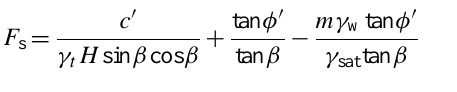
Equation (4) shows that F s decreases with the depth of slid- ing, H . Hence H is taken as the infiltration